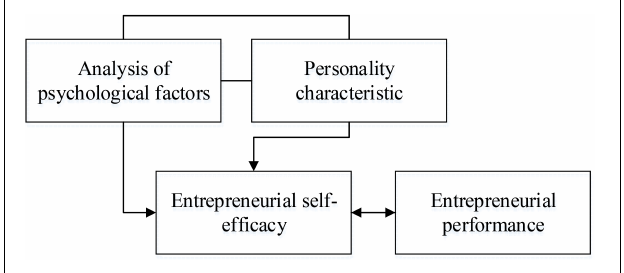
FIGURE 1 | Correlations among psychological factors, entrepreneurial self-efficacy, and entrepreneurial